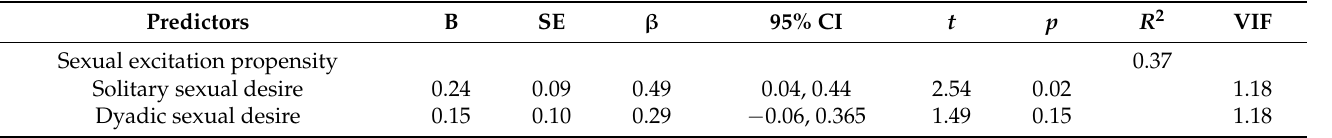
Table 7. Multiple linear regression model to explain the propensity for sexual excitation in